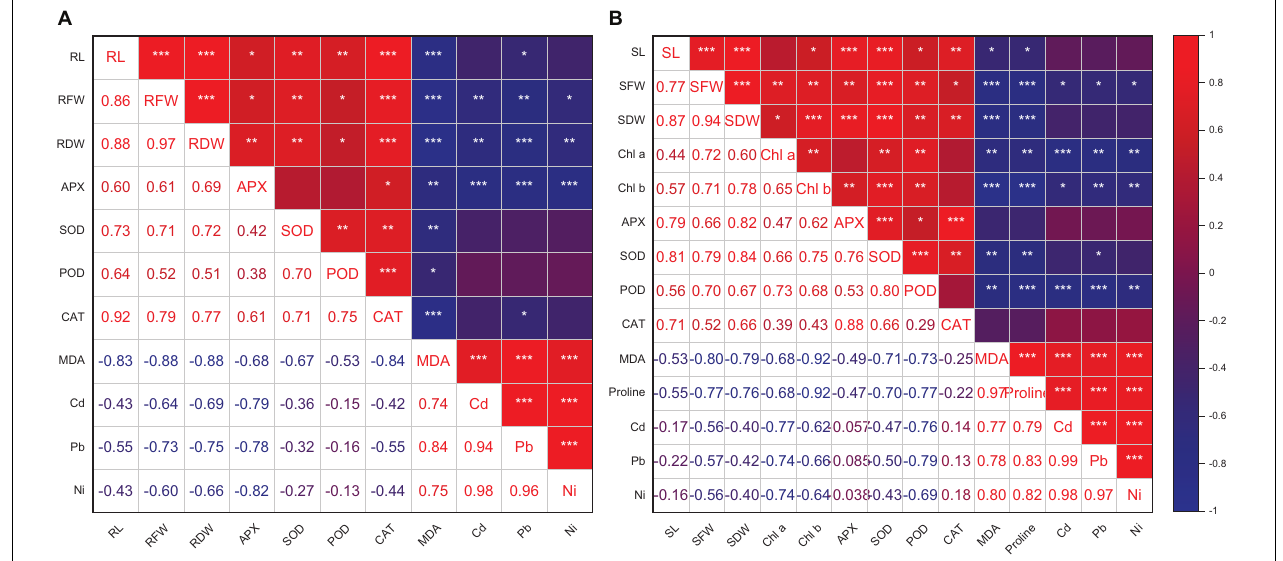
SOD by 18% in comparison to untreated plants. At 50 ppm of HMs, the SOD content ranged from 21.7 to 47 EU mg − 1 protein. A maximum increase of 117% (47 EU mg − 1 protein) was observed in plant roots inoculated with Enterobacter cloacae strain JWM6. In case of 100 ppm, root SOD was in the range of 12.8–34.8 EU mg − 1 protein. Plants treated with the bacterial